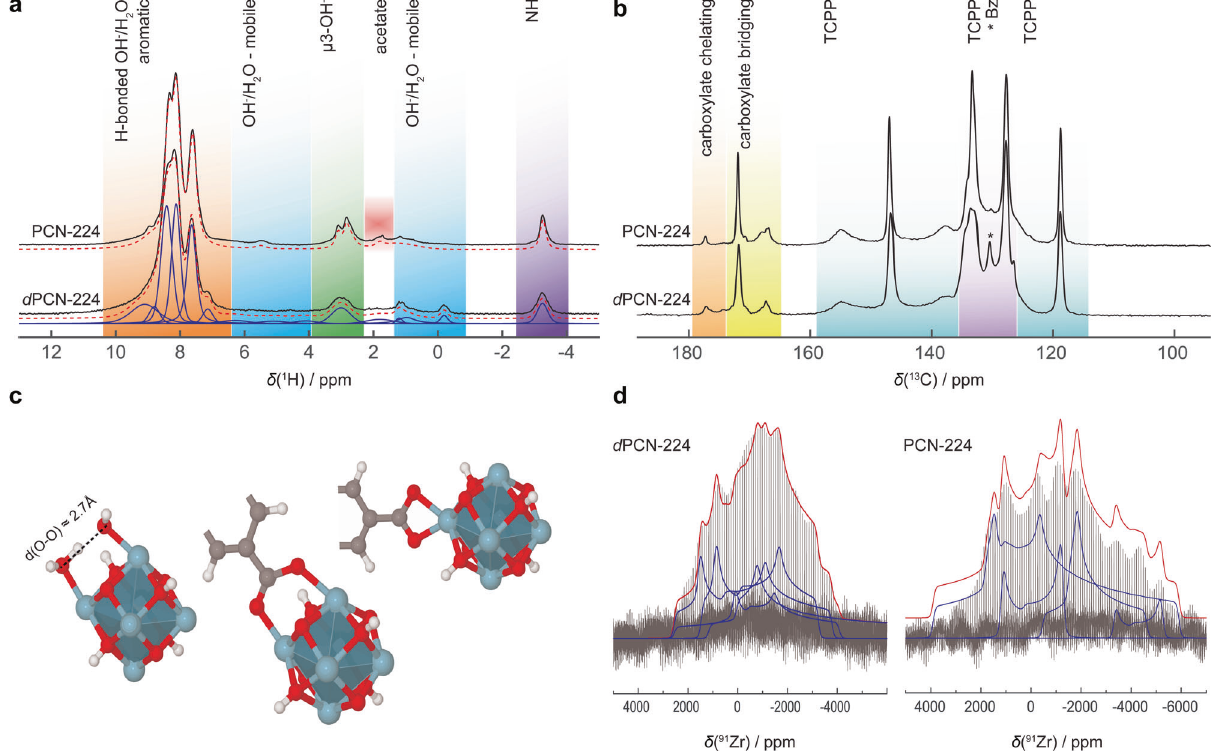
Fig. 6 Solid-state nuclear magnetic resonance (ssNMR) spectroscopic analysis of d PCN-224 (MOF_ZrOCl 2 ) and PCN-224. a 1 H high-resolution magic angle spinning (MAS) NMR spectra recorded at a fi eld of 23.48 T ( ν 0 ( 1 H) = 1 GHz). Characteristic resonances for the aromatic and NH protons of the tetrakis(4-carboxyphenyl)porphyrin (TCPP) linker, the µ 3-OH groups of the Zr 6 O 4 (OH) 4 cluster 57 , hydroxy groups, and water molecules 51,52 are highlighted by color-coded regions. b 13 C cross polarization magic angle spinning (CPMAS) spectra with assignment of the aromatic carbons of the TCPP linkers and benzoic acid (Bz), and chemically inequivalent carboxylic acid groups, characteristic of chelating and bridging binding motifs for the carboxylic acid groups to the cluster. c Main coordination motifs for the Zr 6 O 4 (OH) 4 clusters, from left to right: hydroxy water pairs and bridging and chelating carboxylate groups, which were found in decreasing proportions along this sequence. d 91 Zr quadrupolar Carr-Purcell-Meiboom-Gill variable offset cumulative spectroscopy (qCPMG VOCS) 62 – 65 consisting of at least four different quadrupolar lineshapes (blue), typical for quadrupolar coupling constants between 20 and 25 MHz. Together with the non-axial symmetry of the quadrupolar coupling tensors, an environment with a low symmetry and complex coordination of the Zr atoms is revealed within the cluster. Individual lineshapes and spectral fi ts are illustrated in blue and red,